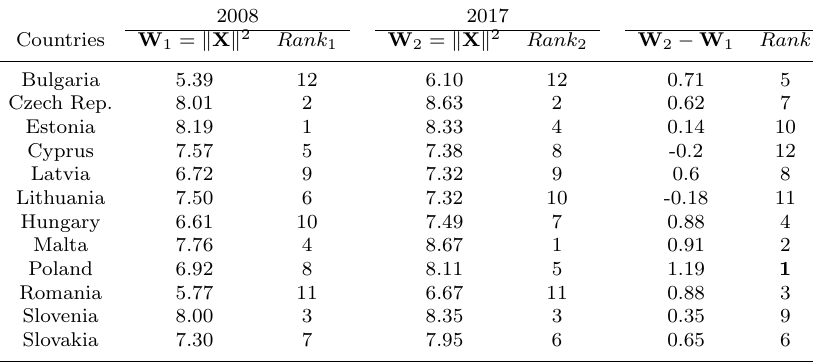
Table 2. Measure values ( (cid:107) x (cid:107) S ) 2 for 12 EU countries that joined the EU in 2004 and 2007. Source: own study based on EUROSTAT data. 2008 2017 Countries W 1 = (cid:107) X (cid:107) 2 Rank 1